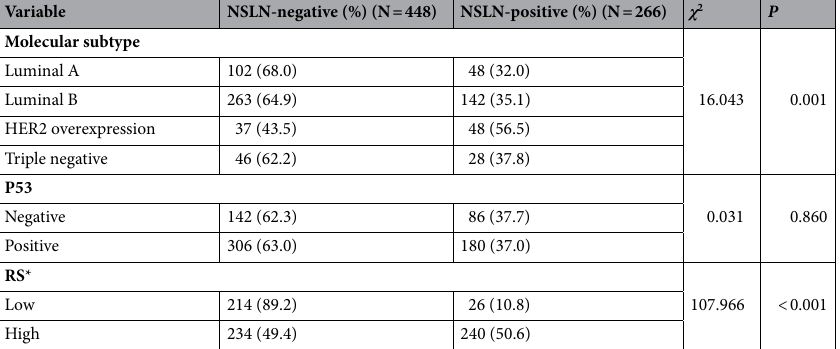
Table 1. Clinicopathological characteristics of the 714 patients in the training cohort. NSLN non- sentinel lymph node, SLNs sentinel lymph nodes, LVI lymphovascular invasion, ER estrogen receptor, PR progesterone receptor, HER2 human epidermal growth factor receptor 2, RS risk score. *The patients were divided into the Low-RS group and High-RS group when the cut-off value of RS was set as